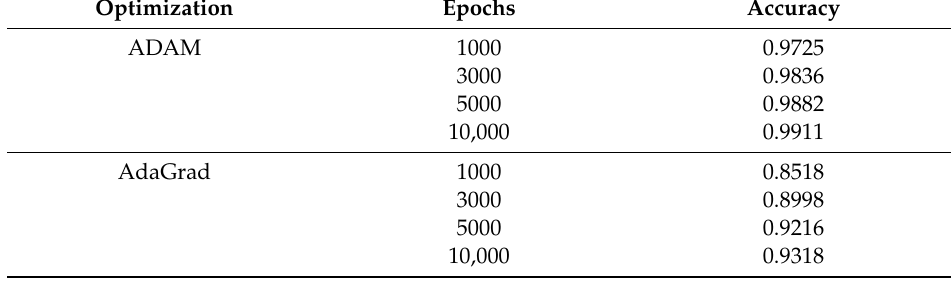
Table 2. Accuracy rate of two algorithm.